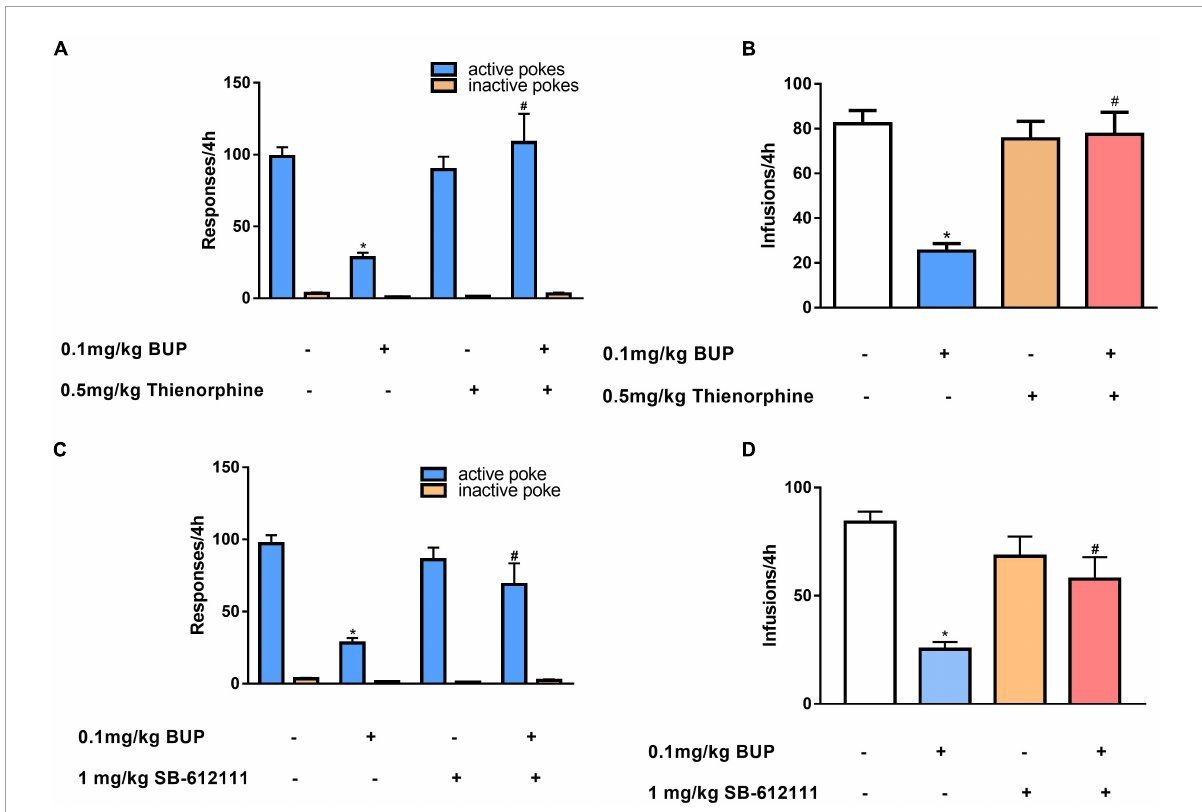
FIGURE3 Effects of thienorphine and SB-612111 on inhibitory action of buprenorphine on methamphetamine self-administration. Data are presented as means ± SEM. The effects of thienorphine pretreatment (0.5 mg/kg, s.c.) with buprenorphine on active or inactive response (A) and total infusions (B) during METH self-administration under FR1 schedule of reinforcement. Buprenorphine reduced the active responses and infusions, thienorphine combined with buprenorphine reversed the inhibitory action of buprenorphine, but thienorphine alone did not affect the responses and infusions. The effects of SB-612111 pretreatment (1mg/kg, s.c.) with buprenorphine on the responses (C) and METH infusions (D) . SB-612111 reversed the inhibitory action of buprenorphine on the active responses and METH infusions, but it alone failed to affect the